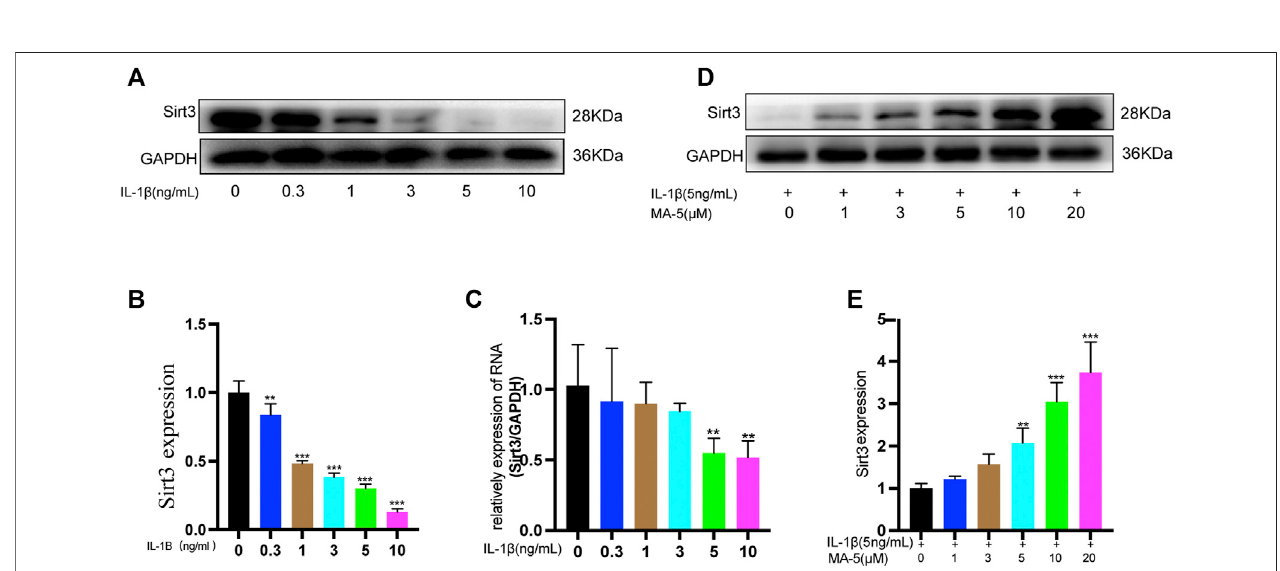
FIGURE 2 | MA-5 prevents the inhibitory effect of IL-1 β on SIRT3 in OA cells. (A,B) Different concentrations of IL-1 β were used to treat OA cells. Western blotting wasused to detect SIRT3. (C) Different concentrations ofIL-1 β were used to treat OA cells, and SIRT3 was detected using RT-qPCR. (D,E) Cells were pre-treated with differentconcentrationsofMA-5,andthenincubatedwith5 ng/mlIL-1 β .After24 h,SIRT3levelwasdeterminedusingwesternblotting.Alldataarepresentedasmean± standard deviation. ** p < 0.01 and * p < 0.05 compared with the control group, as determined using a one-way analysis of variance.